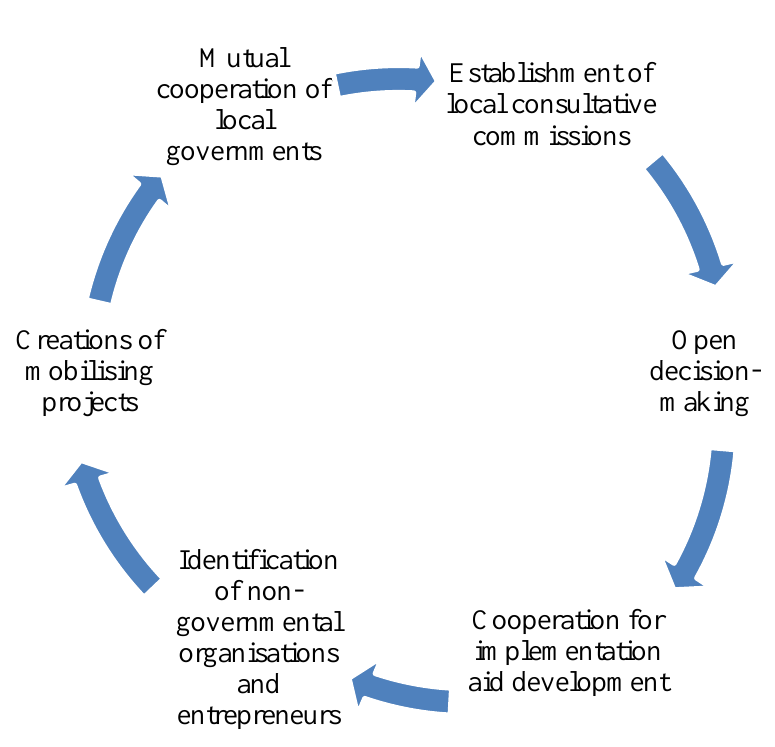
Fig. 2 . Mobilisation cycle of a region (Ministry of Regional Development and Local Government Affairs, 2008) (the figure created by the